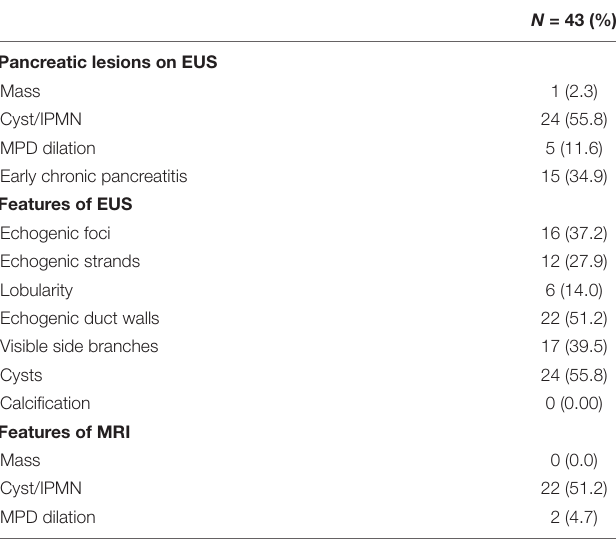
TABLE 3 | Pancreatic features detected in screening by endoscopic ultrasound (EUS) and magnetic resonance imaging (MRI).